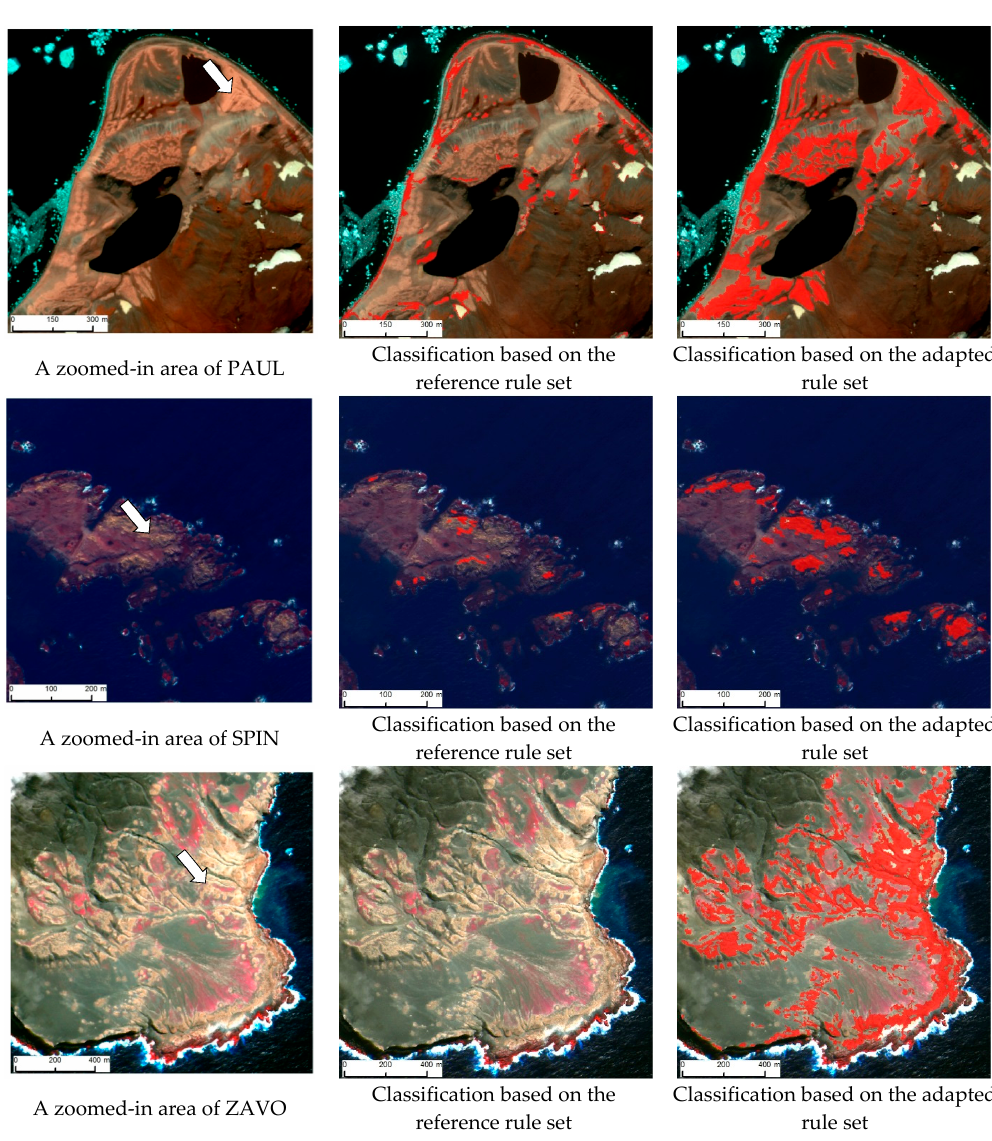
Figure 4. Zoomed-in areas showing: the original image ( left ); classification based on the reference ruleset ( middle ); and classification based on the adapted ruleset ( right ), from the reference study site and the candidate sites. A section of the reference ruleset programmed in Cognitive Network Language (CNL) is also provided at top right. Classified guano is shown in red. Imagery copyright DigitalGlobe, Inc.